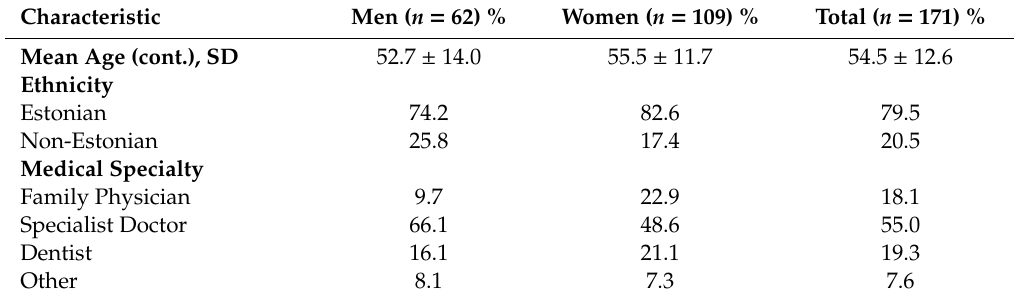
Table 1. Characteristics of the